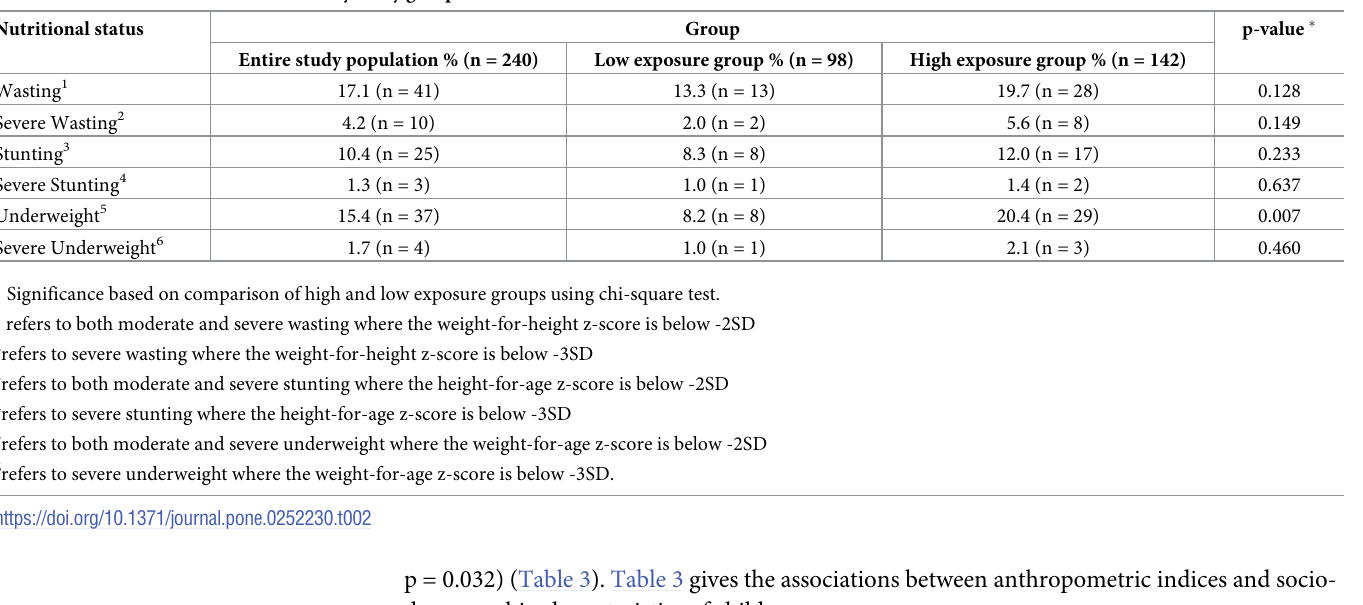
Table 2. Prevalence of nutritional status by study